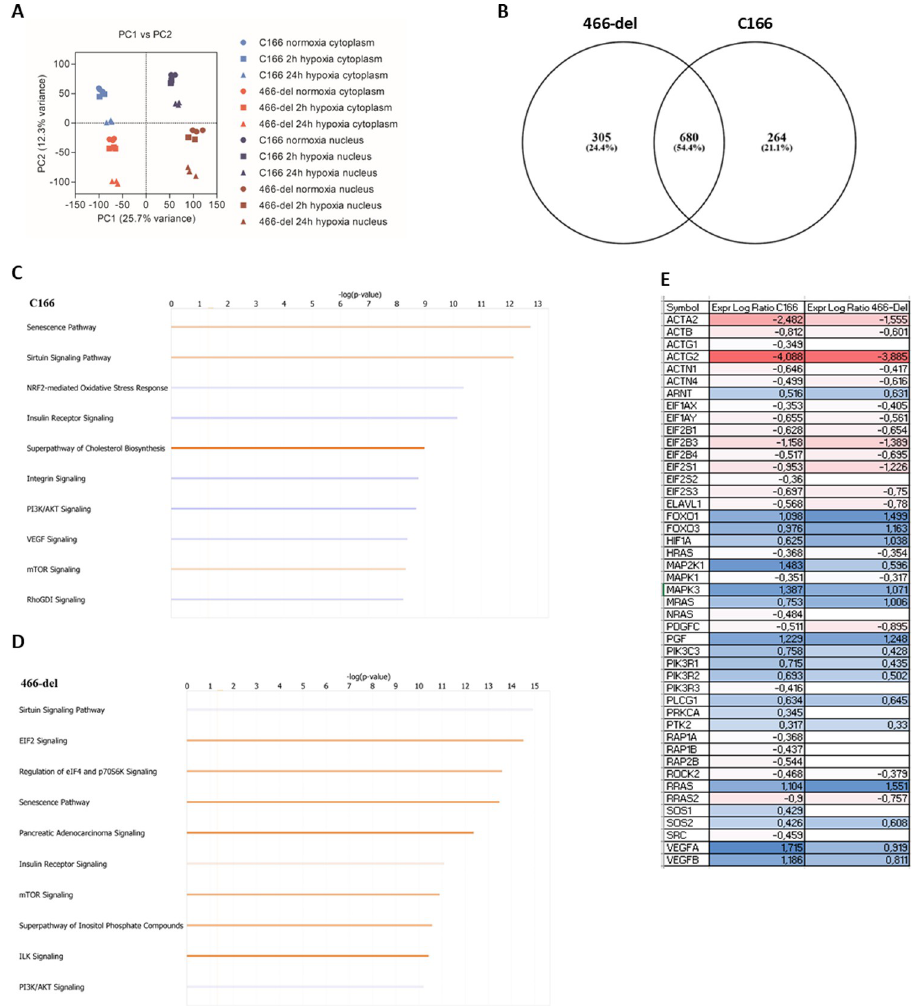
Fig 3. Total transcriptome sequencing of parental and miR-466c deletion cell lines shows significant differences on gene expression profiles. A. Both C166 and 466-del miR-466c deletion cell lines were subjected to hypoxia (2h or 24h), fractionated to nuclear and cytoplasmic samples and analyzed by RNA-sequencing. PCA plot of all sequenced groups shows that the samples are grouped by difference in nuclear and cytoplasmic transcripts, but also by cell line. B. Venn diagram of differentially expressed genes in parental C166 and 466-del deletion cell line shows that most changes in gene expression (680 differentially expressed genes) are still shared in both cell lines. C. Comparison analysis of 24h hypoxia vs. normoxia in cytoplasm of parental C166 cell line. Top 10 canonical pathways altered are shown in the figure, red colour indicates positive z-score, blue indicates negative z-score. D. Comparison analysis of 24h hypoxia vs. normoxia in cytoplasm of 466-deletion cell line. Top 10 canonical pathways altered are shown in the figure, red colour indicates positive z-score, blue indicates negative z-score. E. VEGF signalling pathway members were differentially regulated in C166 and 466-deletion cell line in same fashion, but to different extent.